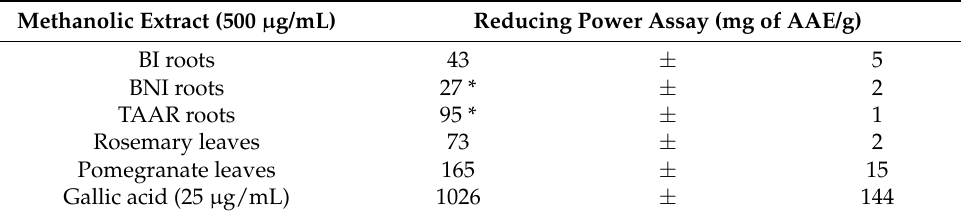
Table 2. Reducing power of plant methanolic extracts.